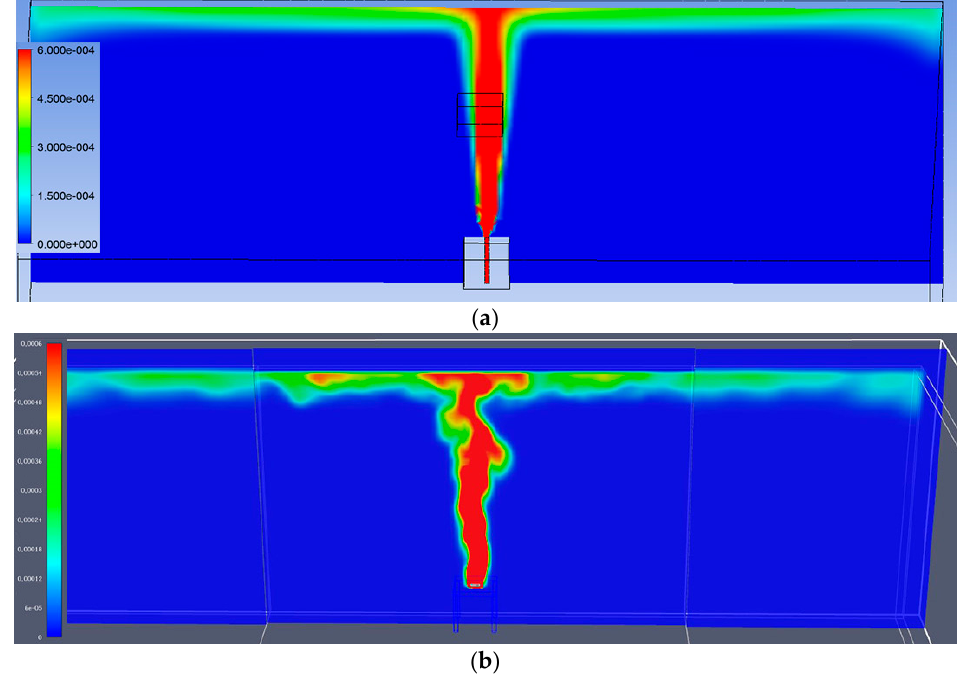
Figure 18. Comparison of hydrogen dispersion for 1.5% concentration of LEL for time 250 s: ( a ) propane release calculated with Ansys software; ( b ) propane release calculated with FDS software.